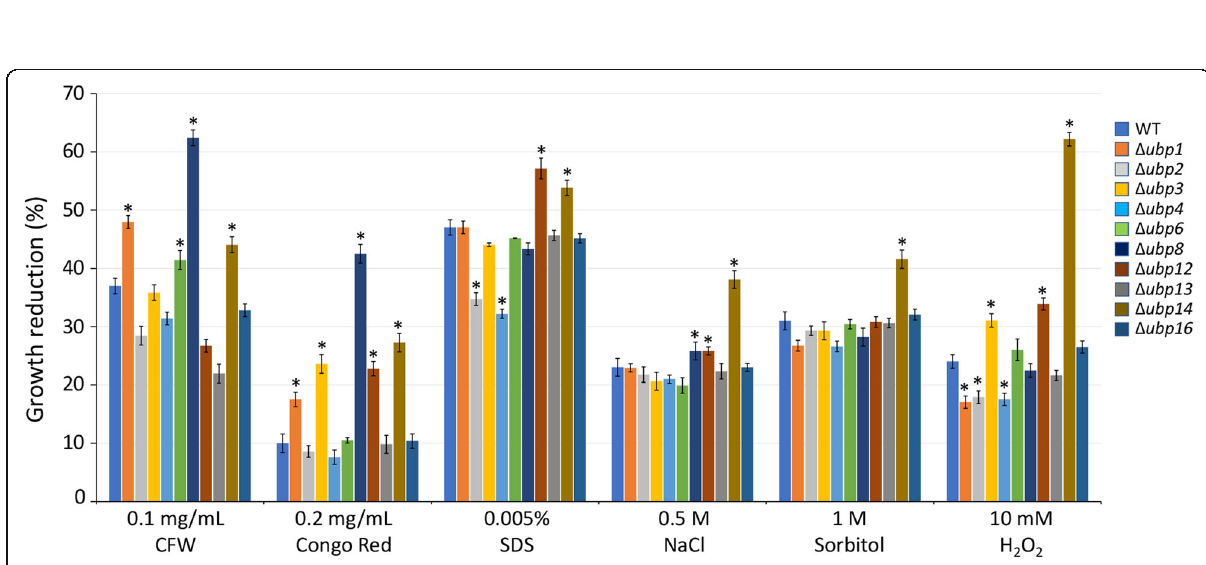
Fig. 8 Statistical analysis of growth reduction rates of colony growth of the ubp mutants under different stresses. The growth reduction was calculated through dividing growth diameter of each strain grown under normal condition by the disparity between one grown under normal condition and stress conditions. Means and standard errors were calculated from three independent replicates. Significant differences were indicated by asterisks ( P <